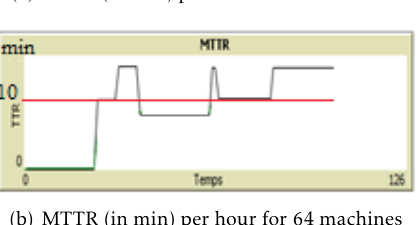
Figure 6. Operating statistic for machines T2 during 126 hours evolution of the MTBF during the 126 hours (color